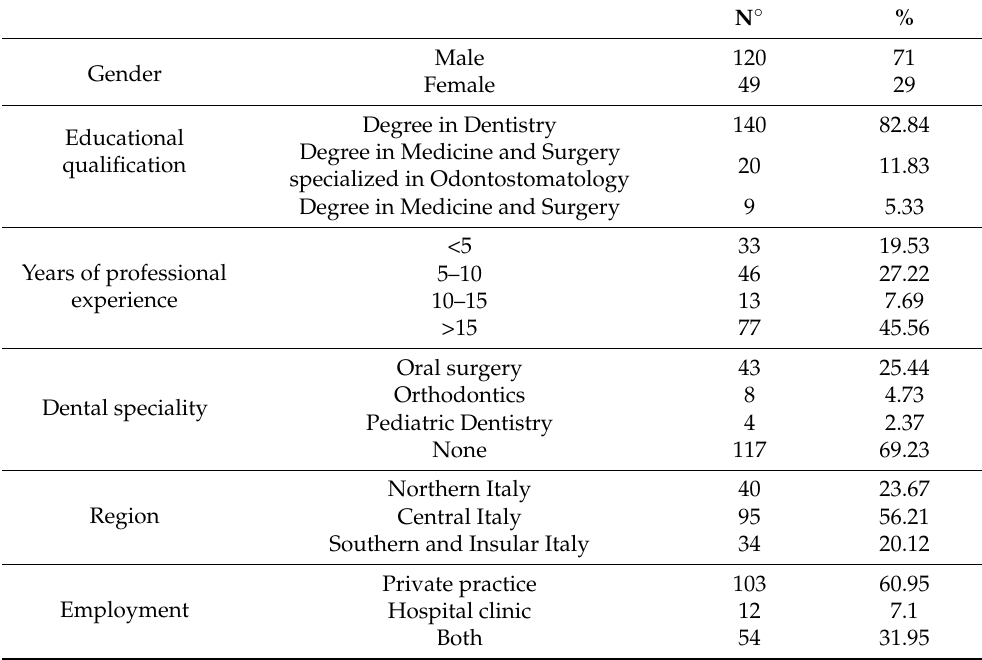
Table 1. Demographic data of participants.